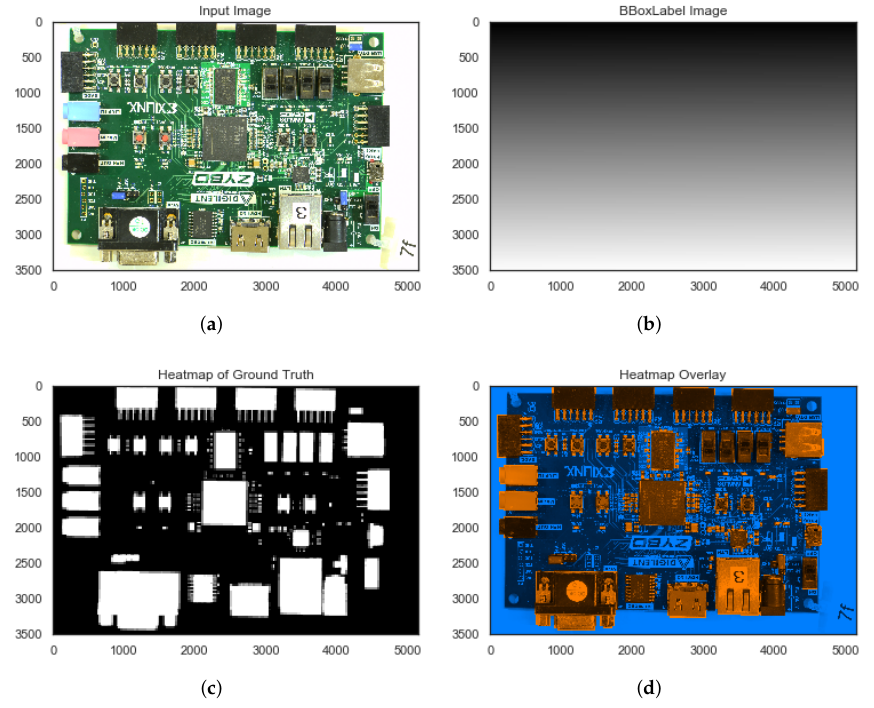
Figure 3. ( a ) The original PCB image; ( b ) the corresponding bbox labels; ( c ) the bbox ground truth heatmap for this PCB image; ( d ) and the heatmap overlay on the PCB